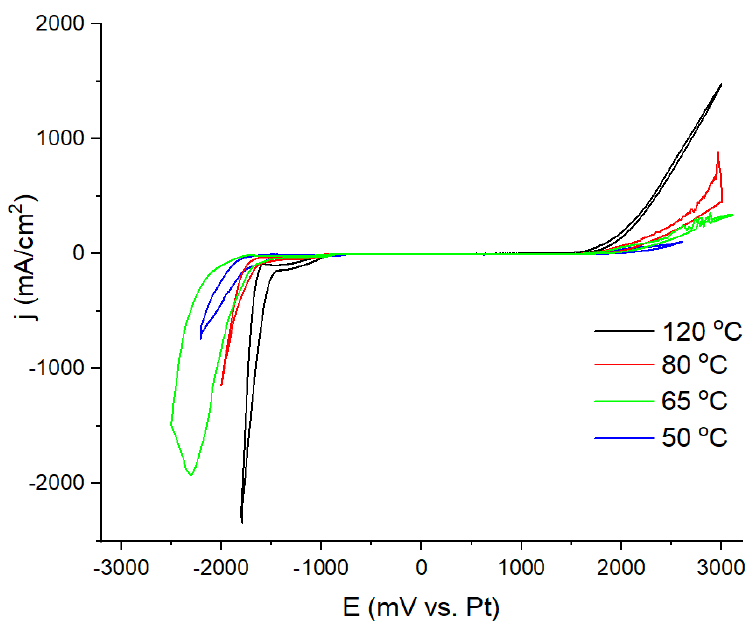
Figure 9. Cyclic voltammograms of the PIL [Pyrr][PTS] at different temperatures.